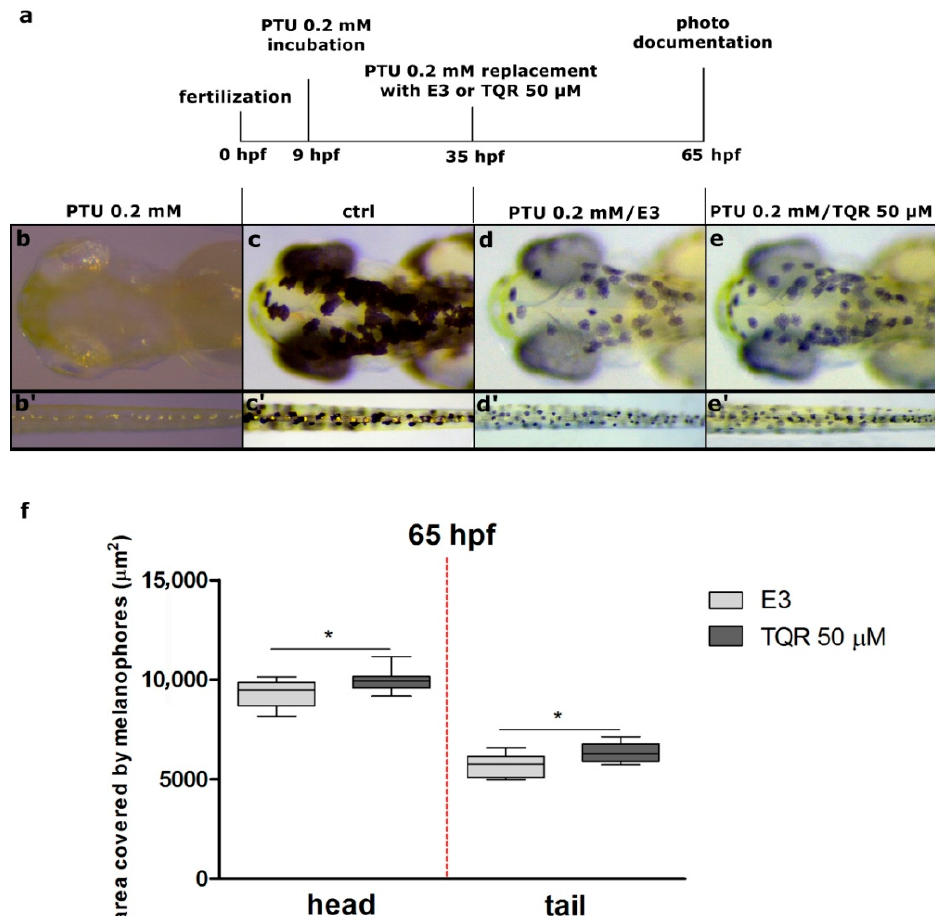
Figure 4. A set of pictures taken at 65 h post fertilization (hpf) showing the melanogenic stimulatory effect of 50 µ M tariquidar (TQR) after 0.2 mM 1-phenyl-2-thiourea (PTU) exposure in larval zebrafish. ( a ) A schematic representation of the schedule of pigmentation rescue investigation. Nine-hpf embryos were pretreated with 0.2 mM PTU. At 35 hpf, all the embryos were washed and immersed in the E3 medium or 50 µ M TQR solution. The incubation after medium replacement lasted until 60 hpf. Photographs present (b,b’ ) larvae treated with PTU from 9 to 65 hpf, ( c,c’ ) control larvae incubated in E3, ( d,d’ ) larvae treated with PTU from 9 to 35 hpf and then replaced with E3, and ( e,e’ ) larvae treated with PTU from 9 to 35 hpf and then replaced with TQR. ( f ) A graph presenting the area covered by melanophores ( µ m 2 ) measured at 65 h post fertilization (hpf) within the dorsal head and tail. Replacement with 50 µ M TQR resulted in a significant increase in the area covered by melanophores ( µ m 2 ), within both the dorsal head and tail, in the TQR-exposed group compared to that determined in the E3 medium treated group (student’s t -test, GraphPad Prism 5, * p <